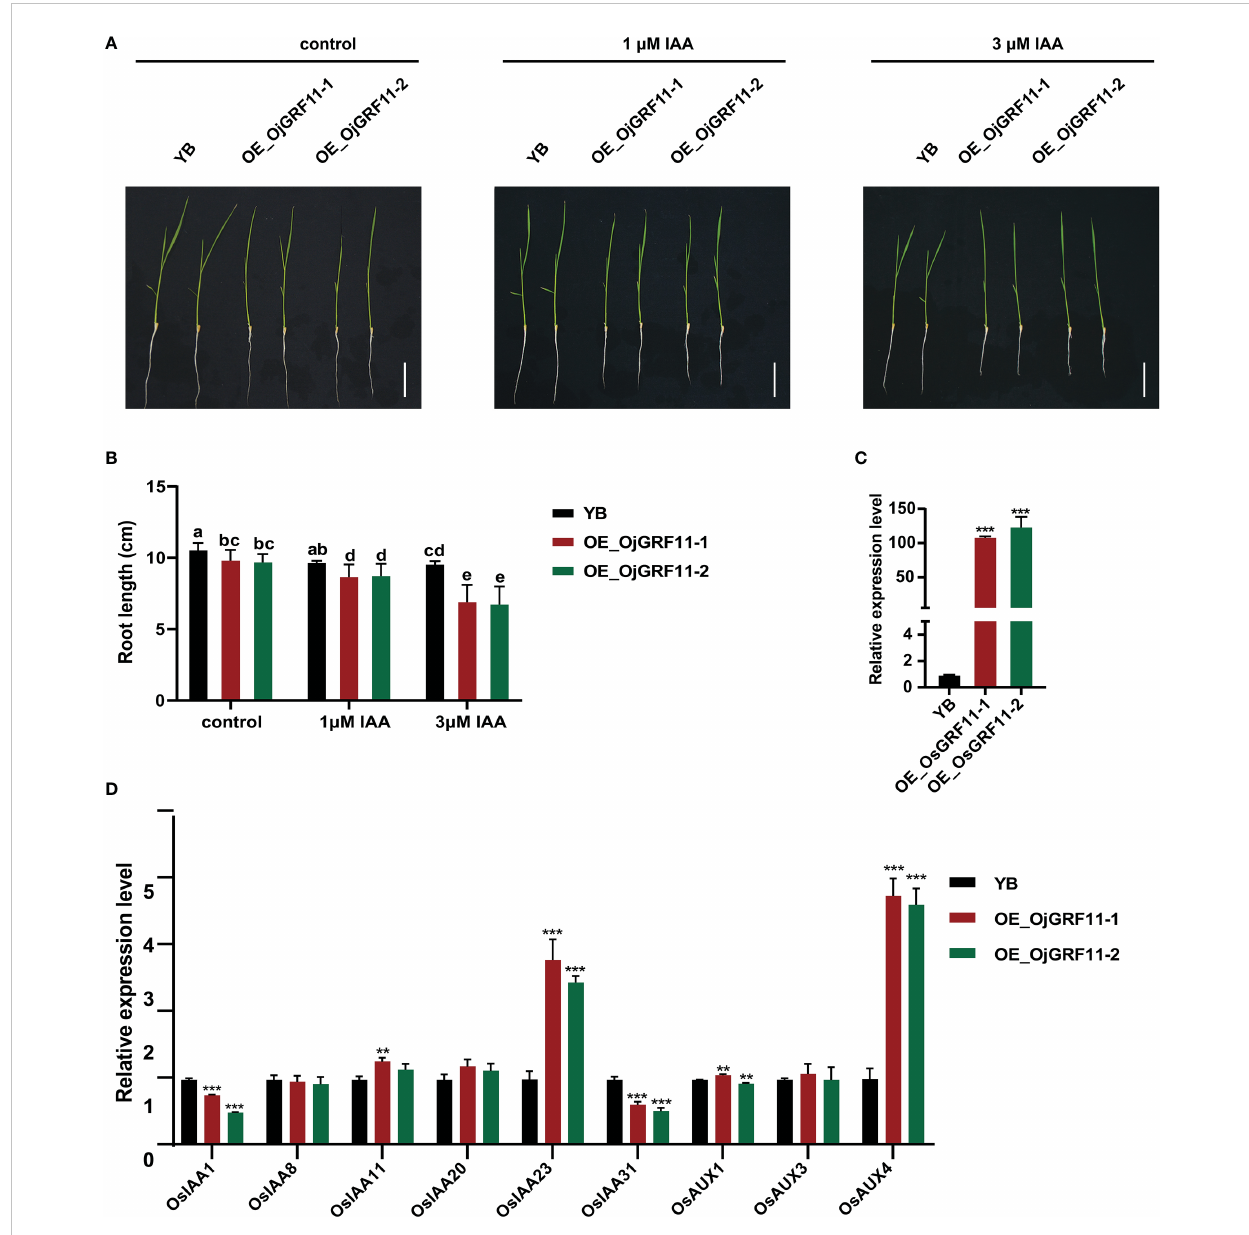
FIGURE 11 OjGRF11 are insensitive to auxin treatment. (A) Characterization of root length in wild ‐ type (WT/YB) and GRF11 over-expression lines under control, l m M IAA, and 3 m M IAA treatments for 7 d. Scale bars = 5 cm. (B) Statistical analysis of root length of in the WT/YB and GRF11 overexpression transgenic plant under control, l m M IAA, and 3 m M IAA treatments for 7 d. The error bars show the standard deviation of the ten biological replicates. Different letters indicate signi fi cant differences ( P < 0.05) determined by Duncan ’ s multiple range test. (C) Expression levels of GRF11 in the WT/YB and OjGRF11 overexpression transgenic plants. (D) Relative expression levels of the OjGRF11 target genes in the transgenic plants compared with in the YB. In (C, D) the expression level was tested by qRT-PCR estimated by the 2 DD CT method. The error bars show the standard deviation of the three biological replicates. ns: p > 0.05, **: p < 0.01, ***: p <